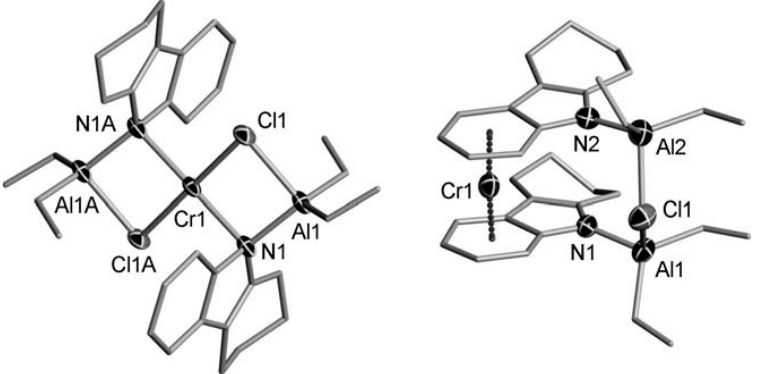
Figure 27. Molecular structures of the complexes Cr01 and Cr02 . Reprinted with permission from [235]. Copyright (2008) Wiley-VCH Verlag GmbH & Co.